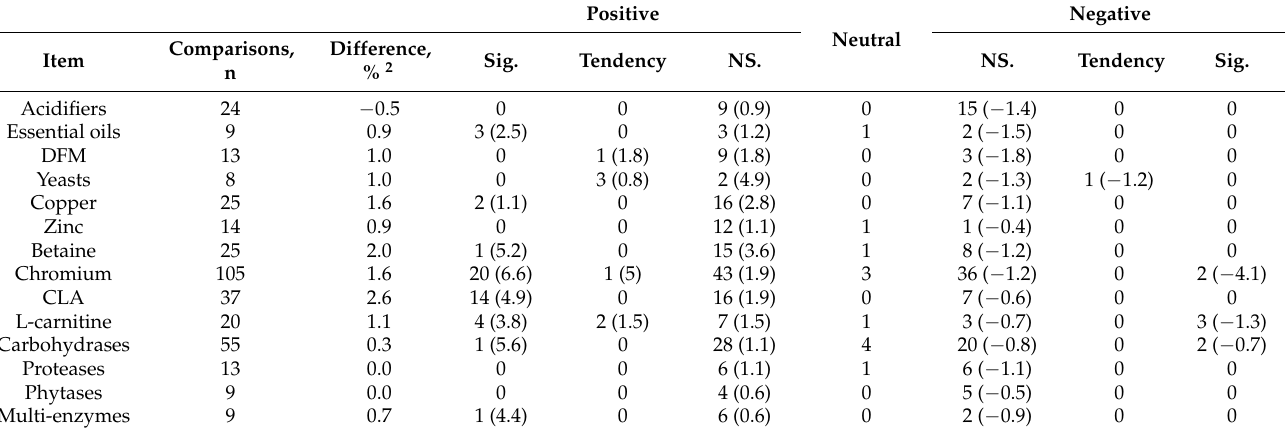
Table 4. Summary of the effects of feed additives on grow–finish pig percentage lean 1,3 .